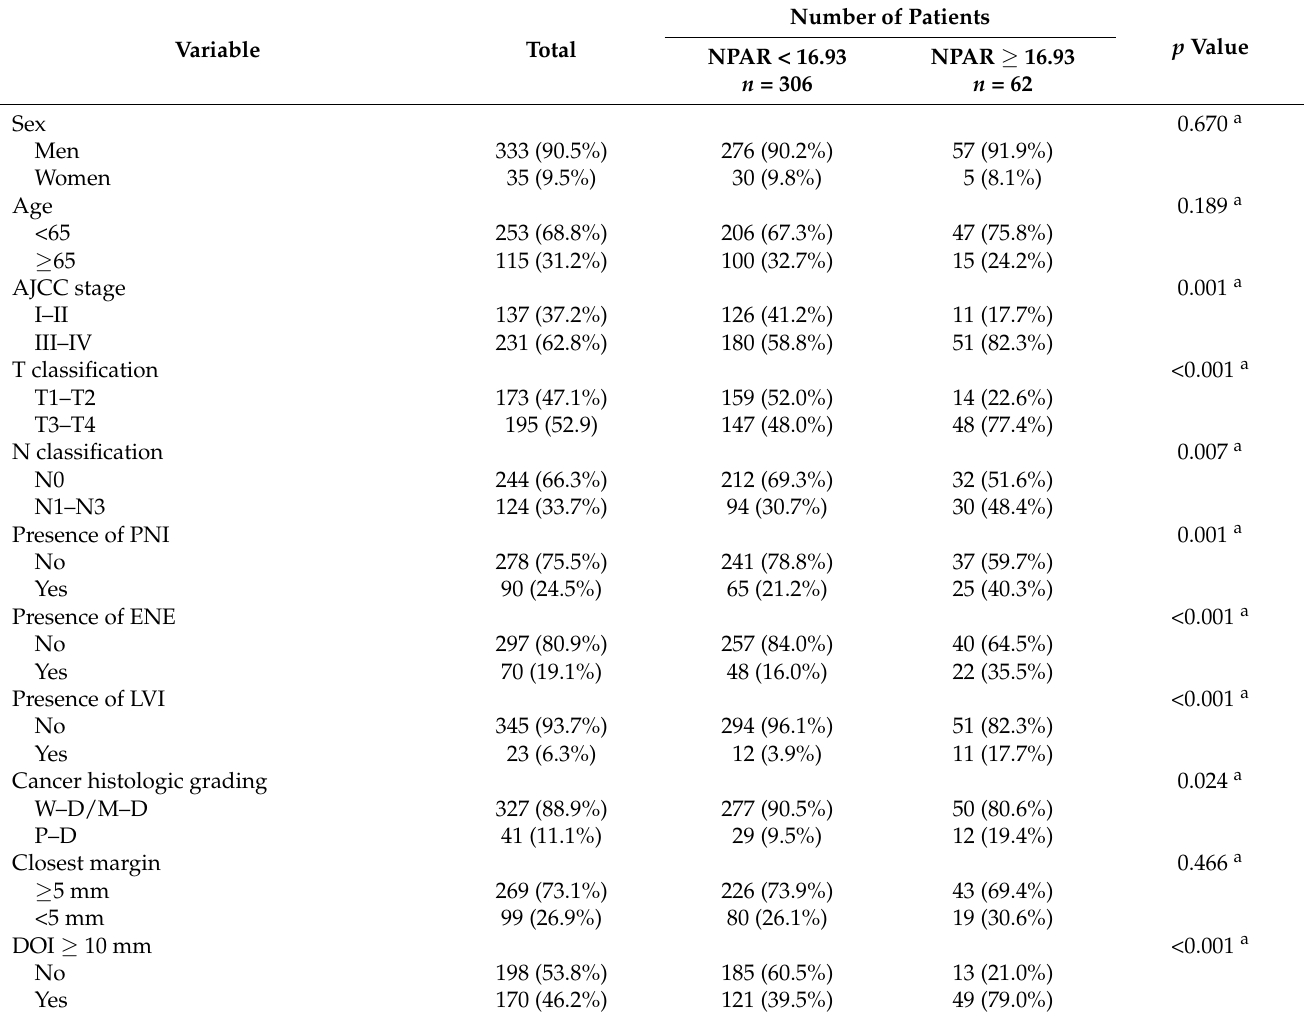
Table 1. Baseline characteristics of study participants and the stratification based on NPAR cutoff